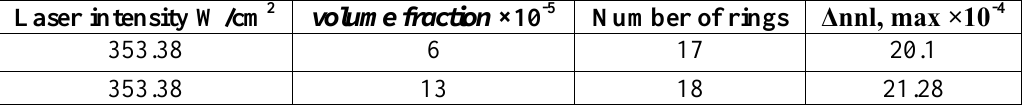
Table 1: The maximum change of nonlinear refractive index and their coinciding at two volume fraction in SWCNTs.